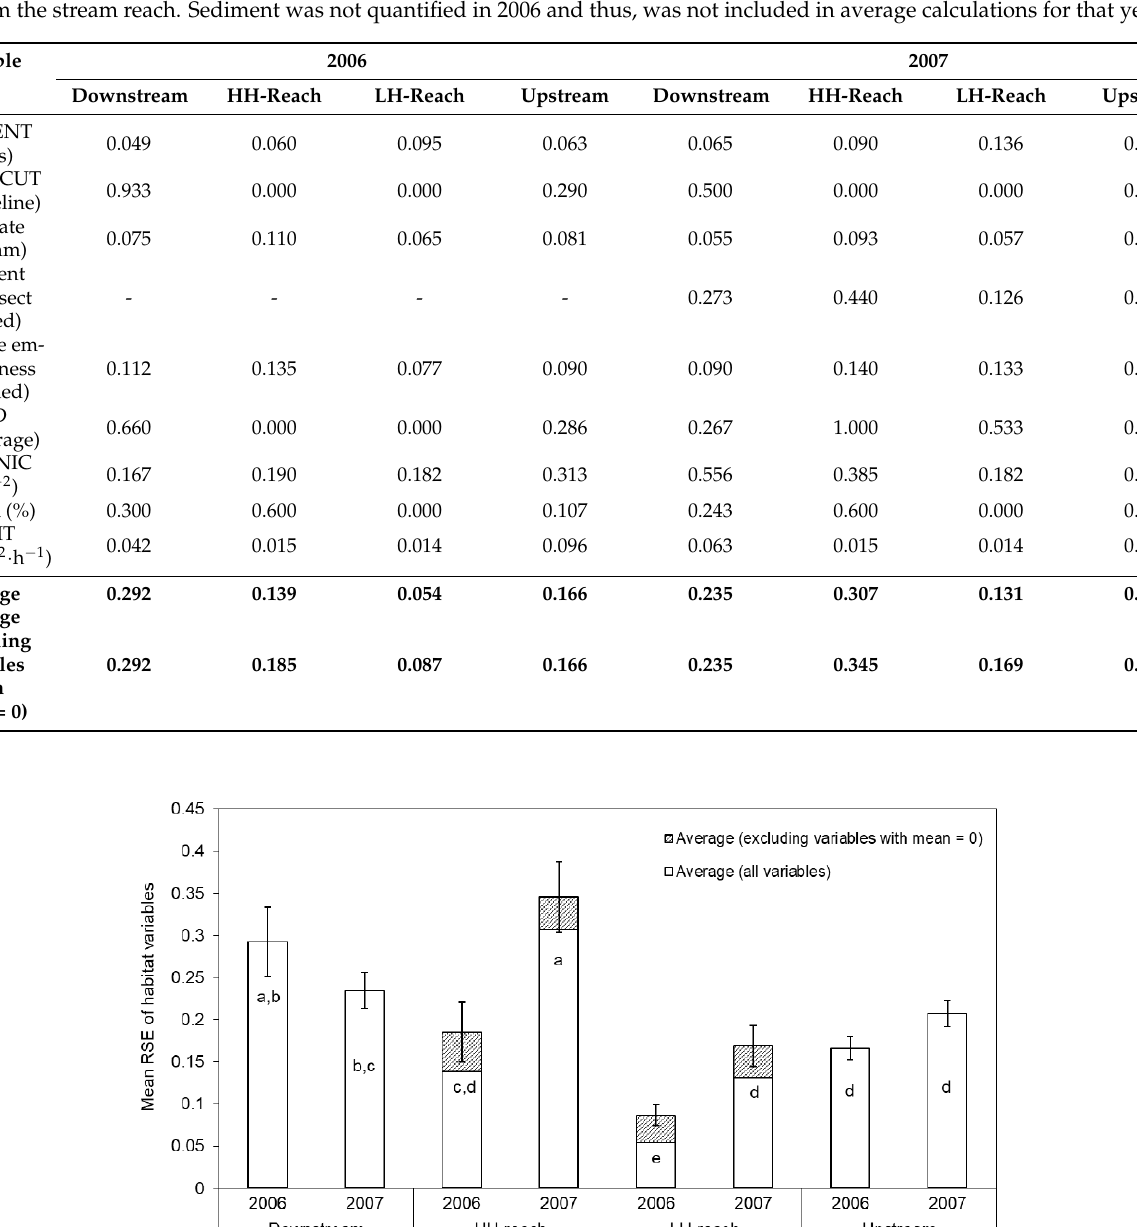
Figure A5. Cyanobacteria colonies ( Nostoc parmelioides ), each containing a Chironomid larva, growing on the surface of a cobble from the LH-reach. The upper surface of the rock was exposed to the current, whereas the lower half was embedded in other cobbles and sediment. Each disk-shaped colony is approximately 1 cm diameter. No other macroinvertebrates were removed prior to the photograph being taken, yet few if any, are visible. Photo by David Pilliod.